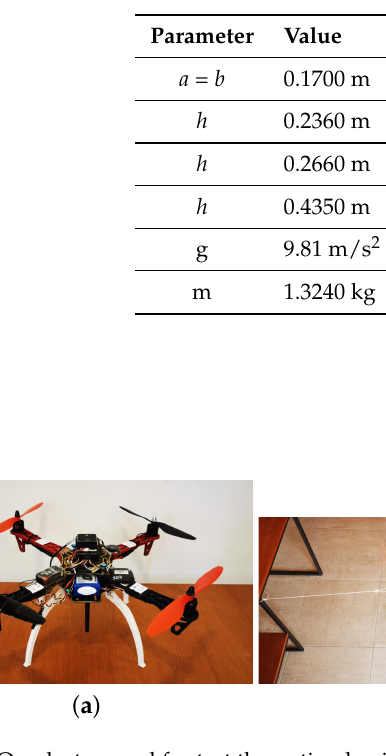
Figure 6. ( a ) Quadrotor used for test the optimal gains for the PID controller. ( b ) Quadrotor with the test base for the roll and pitch axes controller test. ( c ) Quadrotor with the test base for the yaw axis controller